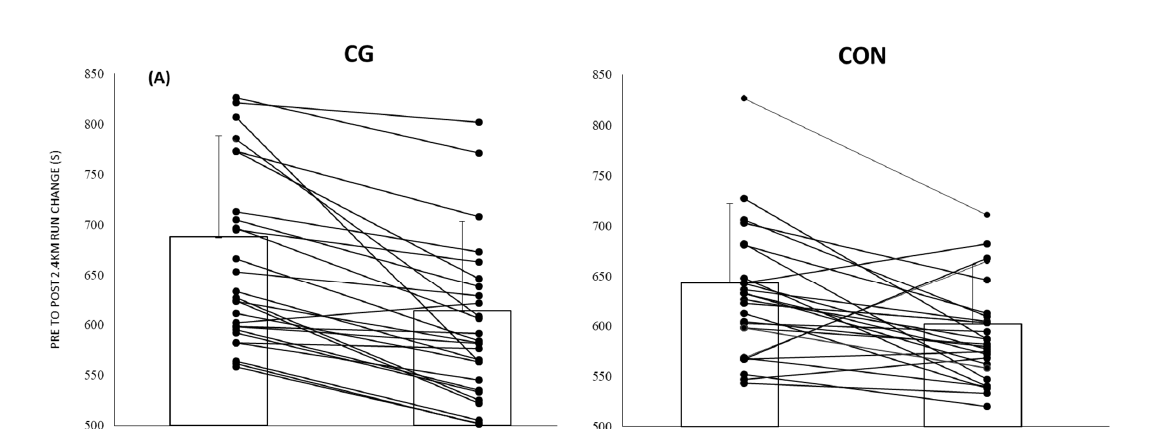
Figure 1. Pre to post performance change for compression garments (CG) and control (CON) groups over the 6 weeks of military training. Boxed columns indicate mean and SD, and lines indicate in- dividual participant results. ( A ) 2.4 km run (s), ( B ) press-ups (repetitions), ( C ) curl-ups (repetitions).